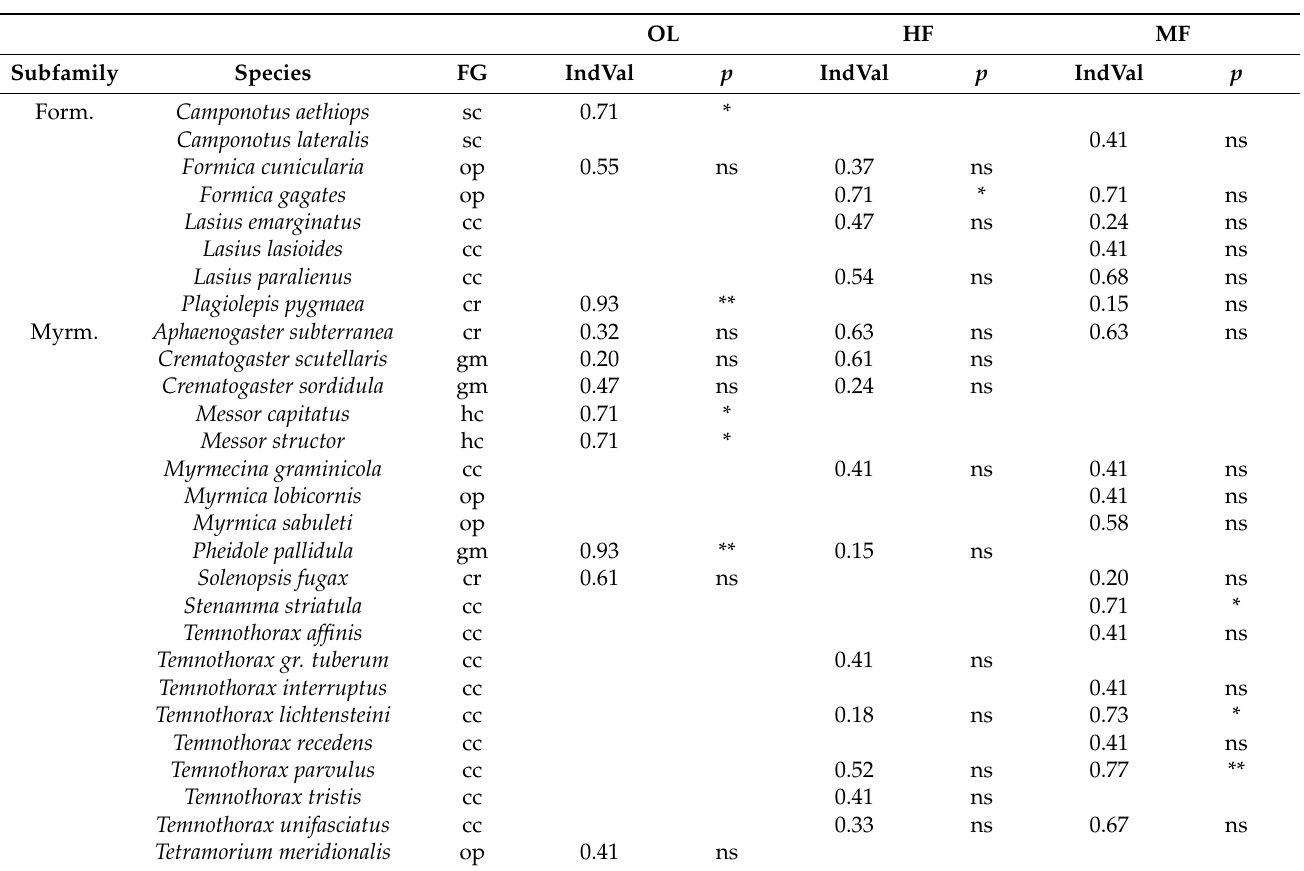
Table 1. Functional group (FG), IndVal index (IndVal), and its significance ( p ) of the species collected in the three habitats by pitfall trap sampling. Form. = Formicinae; Myrm. = Myrmicinae; Significance levels: ns, not significant; * < 0.05; ** < 0.01. Functional groups: cc, cold-climate specialist; cr, cryptic species; hc, hot-climate specialist; gm, generalized Myrmicinae, op, opportunist; sc, subordinate Camponotini.